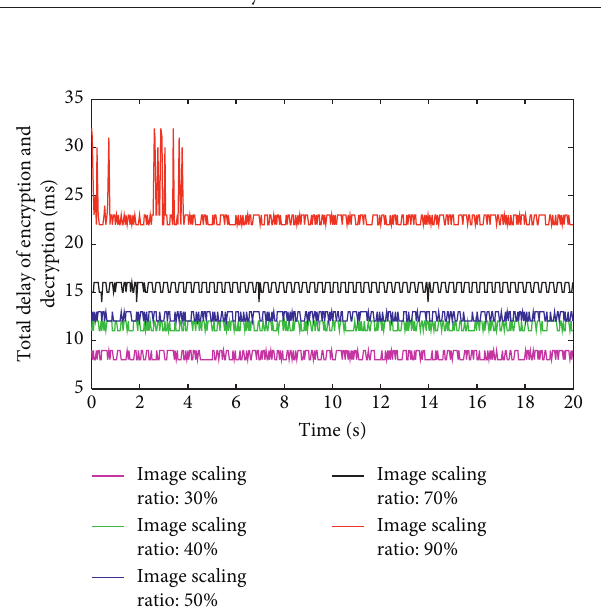
Figure 10: Total delay under different scaling